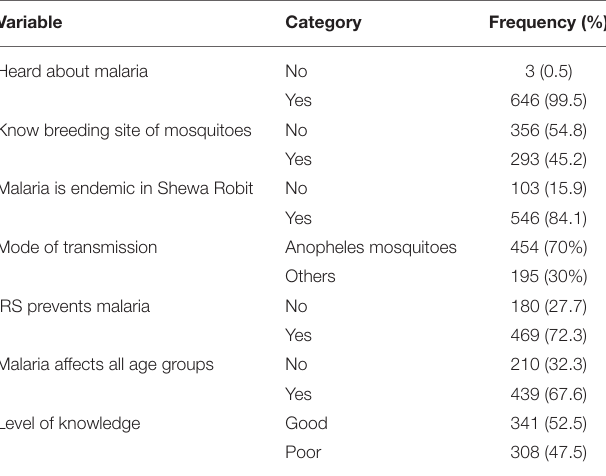
Malaria affects all age groups